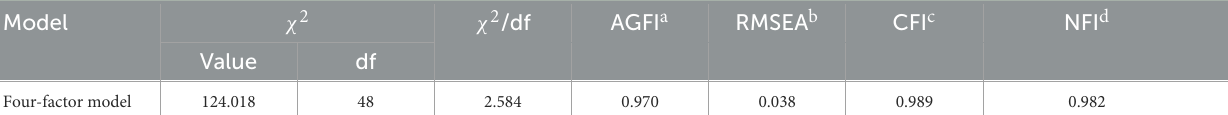
TABLE 4 Fit indices of four-factor model ( N = 1,123).